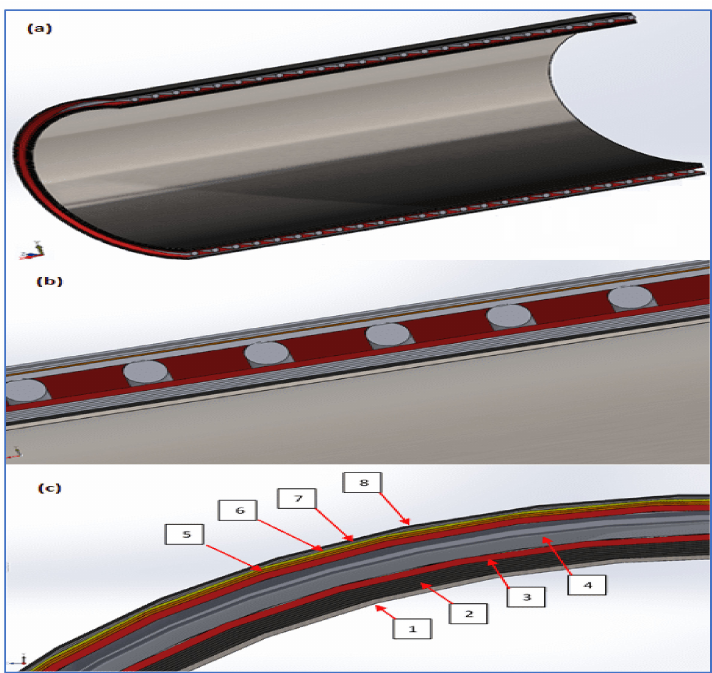
Figure 5. Cross-section through hose showing layers with the helix reinforcement in ( a ) open view, ( b ) closed view, and ( c ) labelled section of layers for the liner ( 1 ), main plies ( 2 ), filler ( 3 ), steel helix ( 4 ), holding plies ( 5 ), subcover ( 6 ), filler ( 7 ) and main plies ( 8